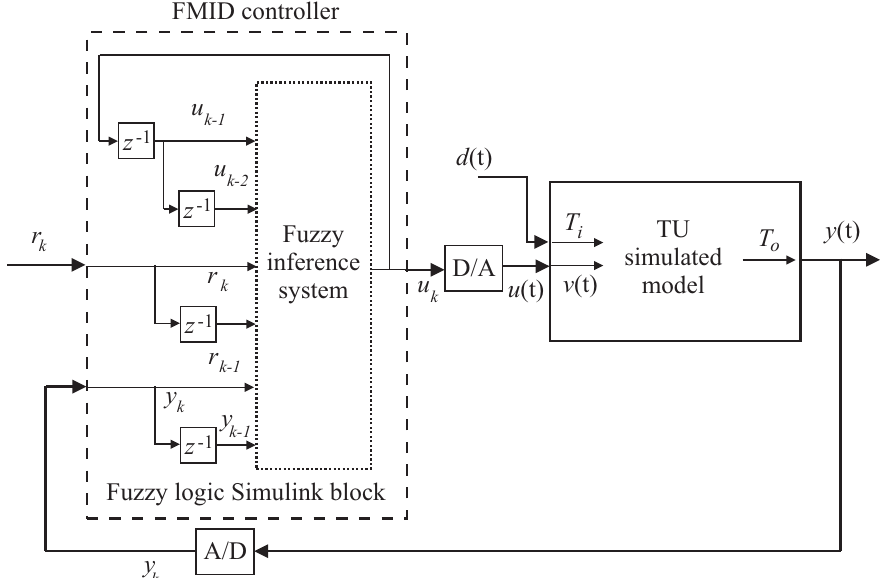
Figure 8. Diagram of the TU module with the TS fuzzy regulator identified from the FMID